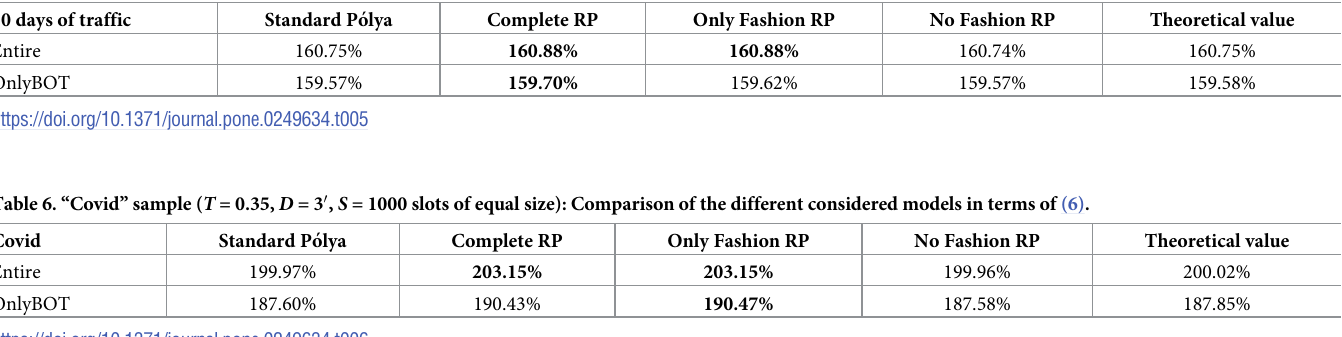
Table 5. “10 days of traffic” sample ( T = 0.35, D = 30 00 , S = 100 slots of equal size): Comparison of the different considered models in terms of (6). 10 days of traffic